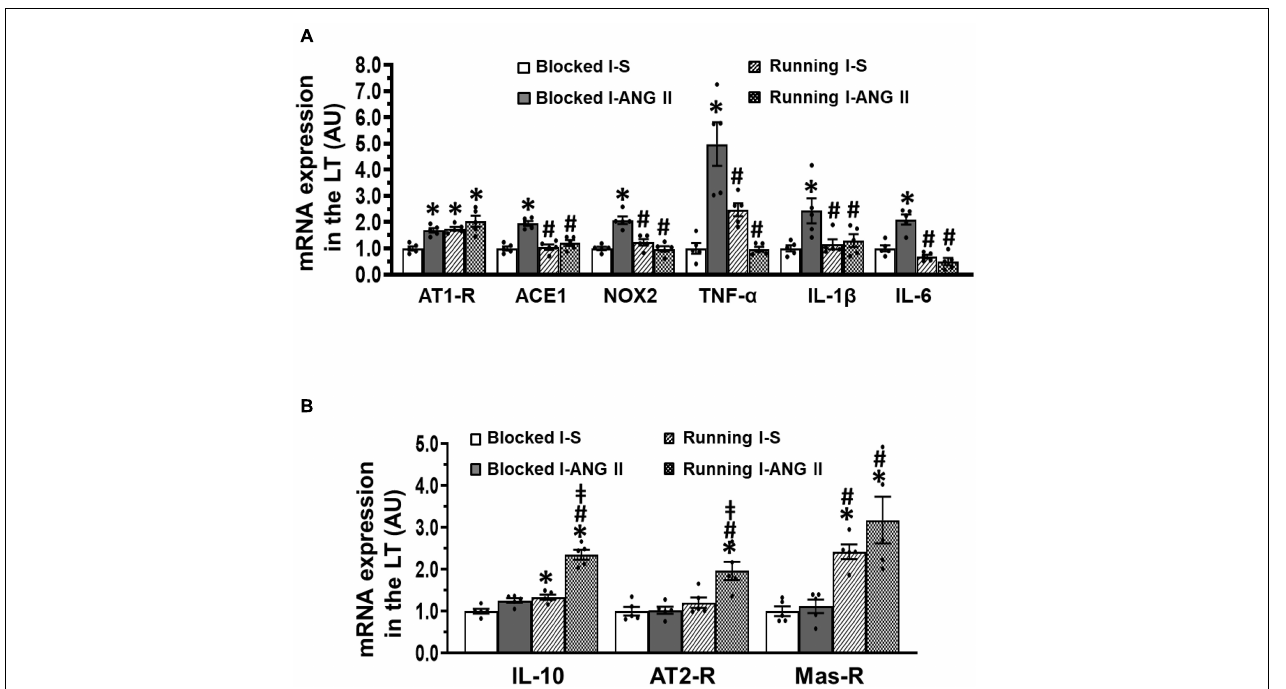
FIGURE 6 | Comparison of the mRNA expression of renin-angiotensin system components, NADPH oxidase and proinflammatory cytokines in the lamina terminalis (LT) in sedentary (Blocked) or exercise (Running) rats after Delay period of the Induction-Delay-Expression (I-D-E) paradigm. (A) mRNA expression of prohypertensive components; (B) mRNA expression of antihypertensive components ( n = 5/group; one-way ANOVA was used for analysis followed by Tukey’s post-hoc tests; p < 0.05; ∗ vs. Blocked I-S; # vs Blocked I-ANG II; } vs. Running